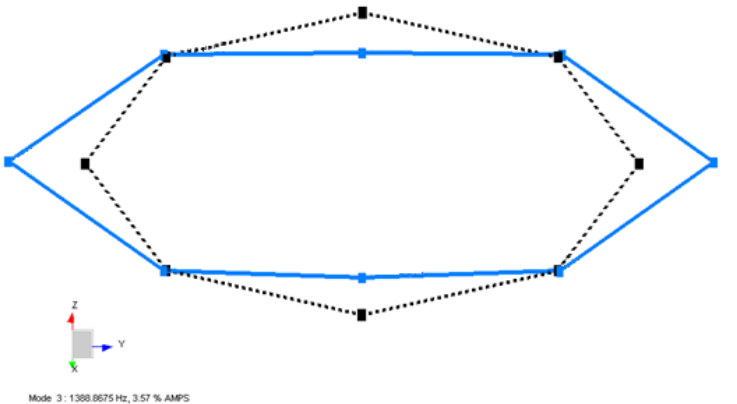
Figure 11. Second mode shape obtained from LMS Test Lab software for a Type-1 coil sample.